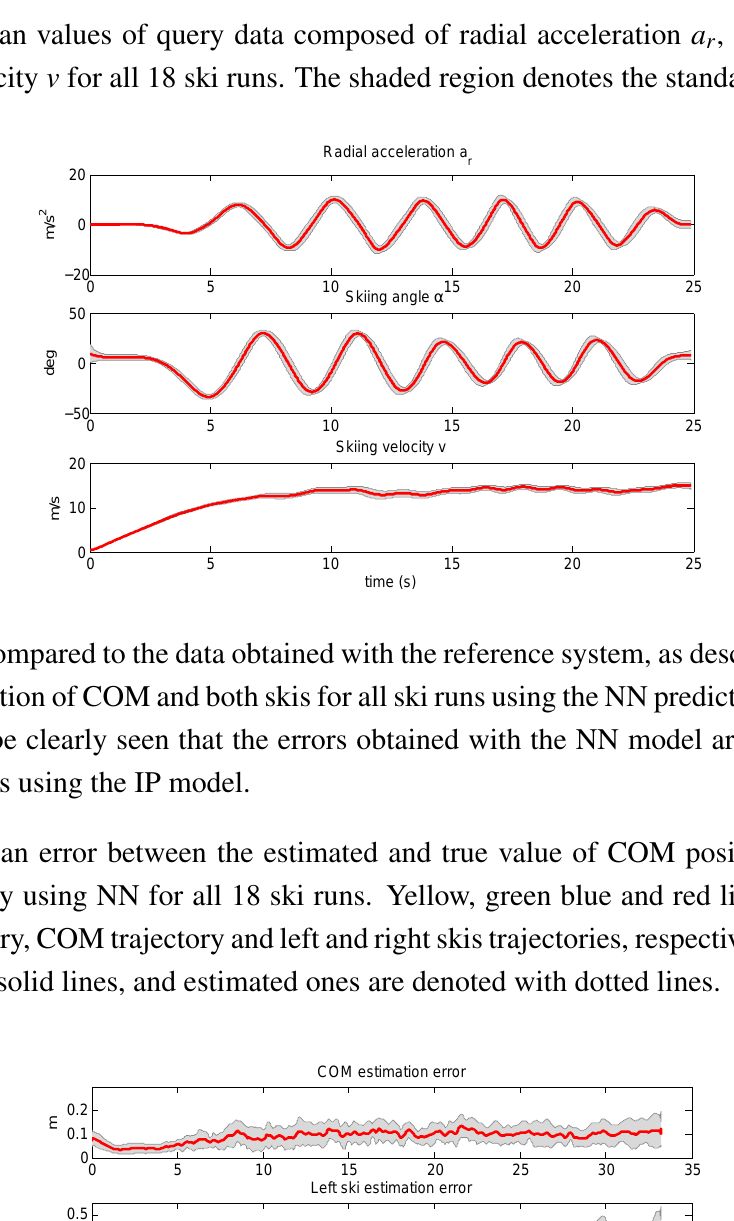
r , skiing angle α